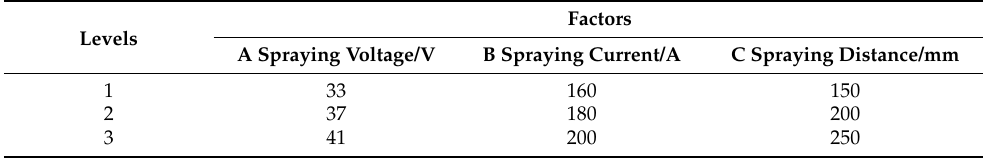
Table 3. Factors and levels of orthogonal